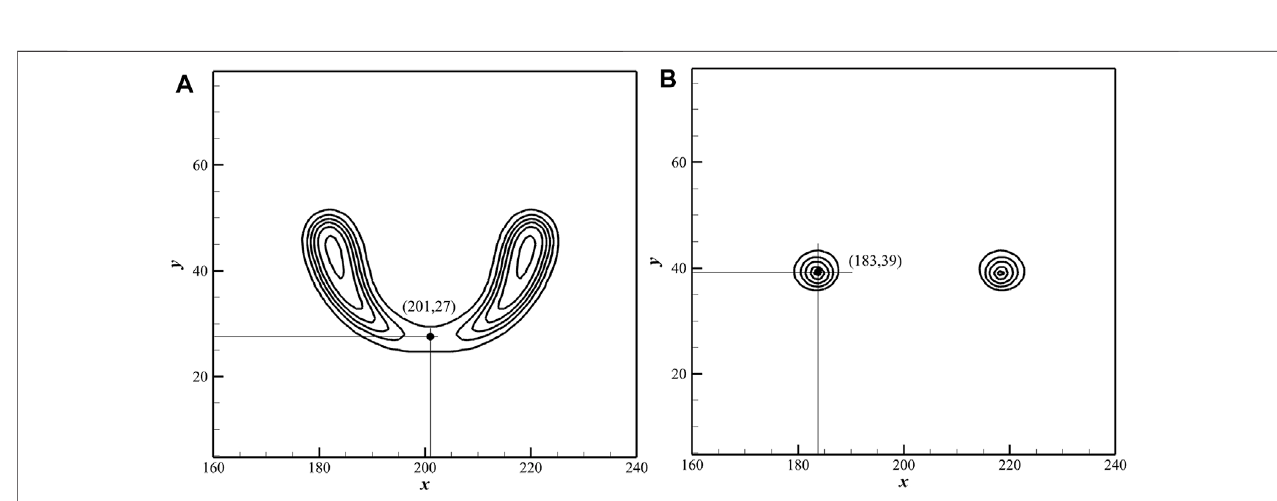
FIGURE 8 | (A) Coordinate of the temperature measurement point during the fi rst collapse; (B) Coordinate of the temperature measurement point during the second collapse.